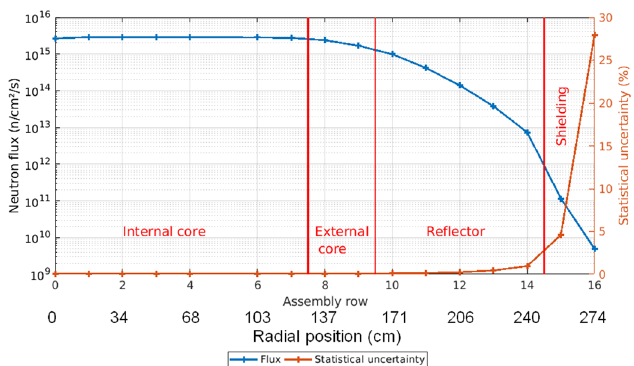
Fig. 4. Radial traverse of the neutron fl ux obtained with a TRIPOLI-4 ® criticality calculation.